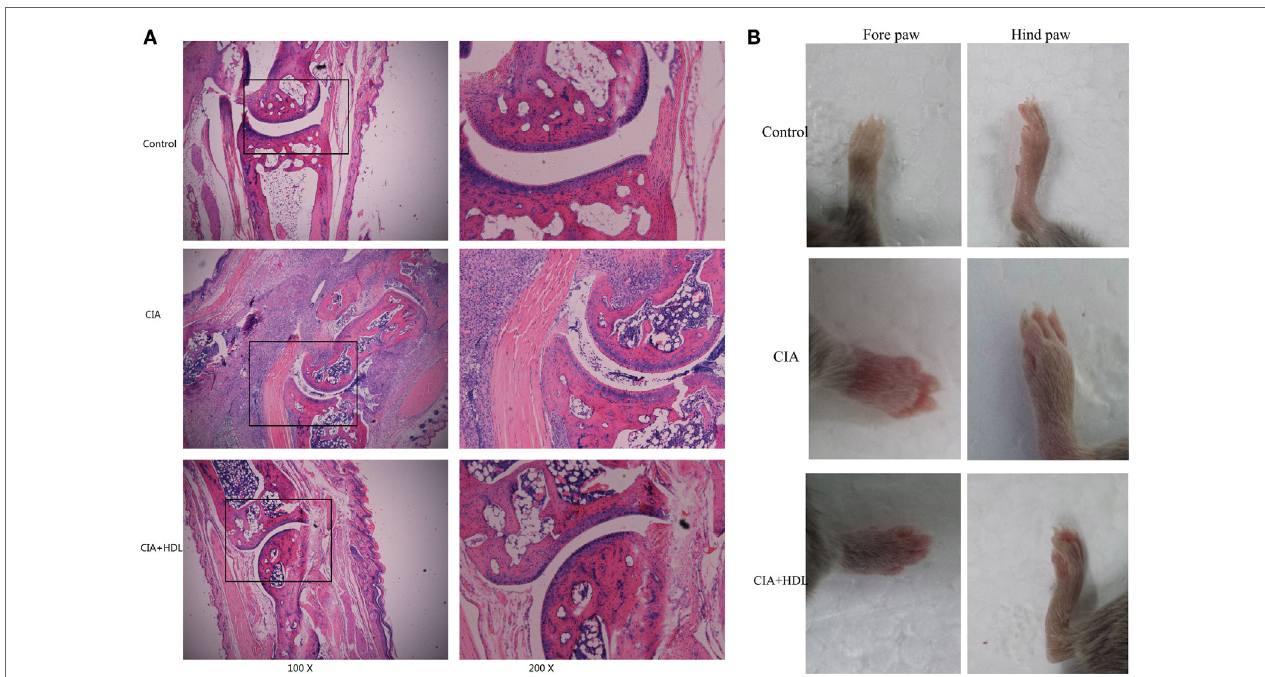
FigUre 4 | Pathological analysis of mice ankle joints. (a) Hematoxylin and eosin staining of the ankle joint; (B) the forepaw and hind paw of the mice. Compared with the control group, the joints of the mice in the collagen-induced arthritis (CIA) group exhibited significant pathological changes, while after treatment with high-density lipoprotein (HDL), the pathological changes were significantly decreased (a) . We could see in (B) that treatment with HDL significantly reduced paw swelling.